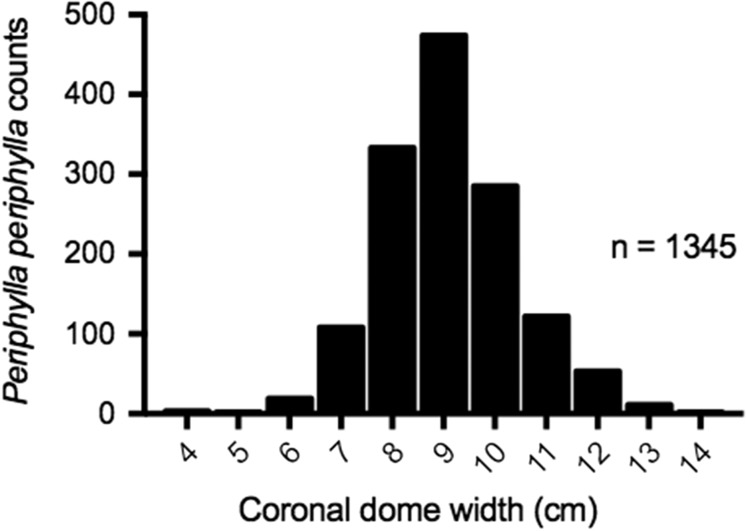
CD width (cm) of Lurefjorden P. periphylla total catch collected with Harstad trawl during day and night on 7 and 8 February 2010 (mean CD = 8.85 ± 1.33 cm). See Table I for sampling parameters.